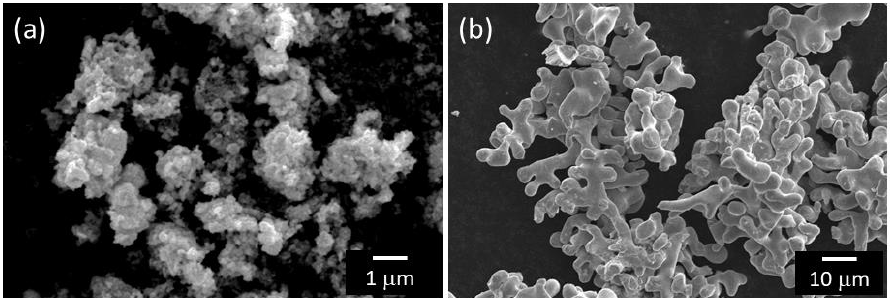
Figure 5. Scanning electron microscopy (SEM) images of ( a ) prepared PdO and ( b ) Pd obtained by heating PdO at 900 °C for 2 h.